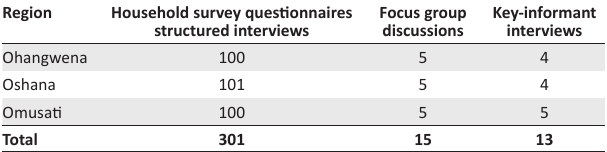
FIGURE 1: A map illustrating 14 administrative regions of Namibia. TABLE 1: Number of household survey questionnaires completed, focus group discussions held and key-informant interviews conducted during phases 1 and 2. Region